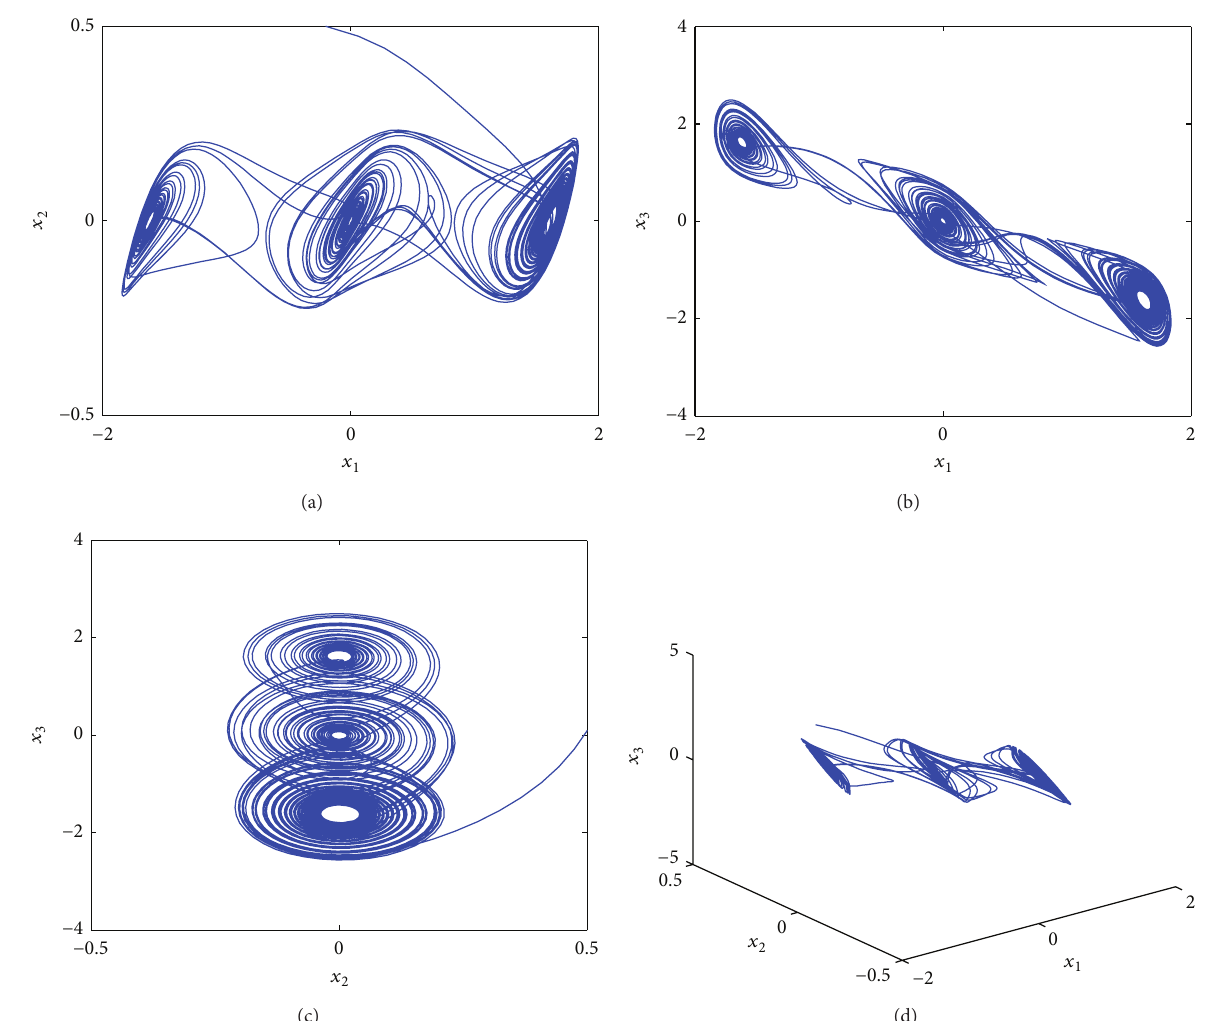
Figure 3: Chaotic attractors in the fractional order Chua system with 𝛼 = 0.99 . The panels (a), (b), (c), and (d) show the 𝑥 2 − 𝑥 1 , 𝑥 3 − 𝑥 1 , − 𝑥 𝑥 3 2 , and 3D views,